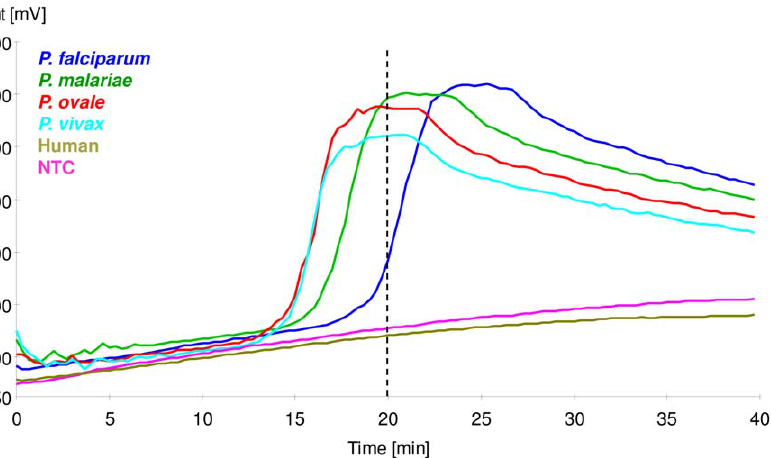
Figure 2. Amplification of the four human-infecting Plasmodium species using the RealAmp method. Plasmodium genus-specific primers were used to amplify the 18s ribosomal RNA gene in P. falciparum, P. vivax, P. malariae and P. ovale parasites. Amplification curves (positive) were observed for all the four species within 20 minutes (vertical dotted line). No amplification was seen with malaria-free human DNA (Human) or in the no template control (NTC).